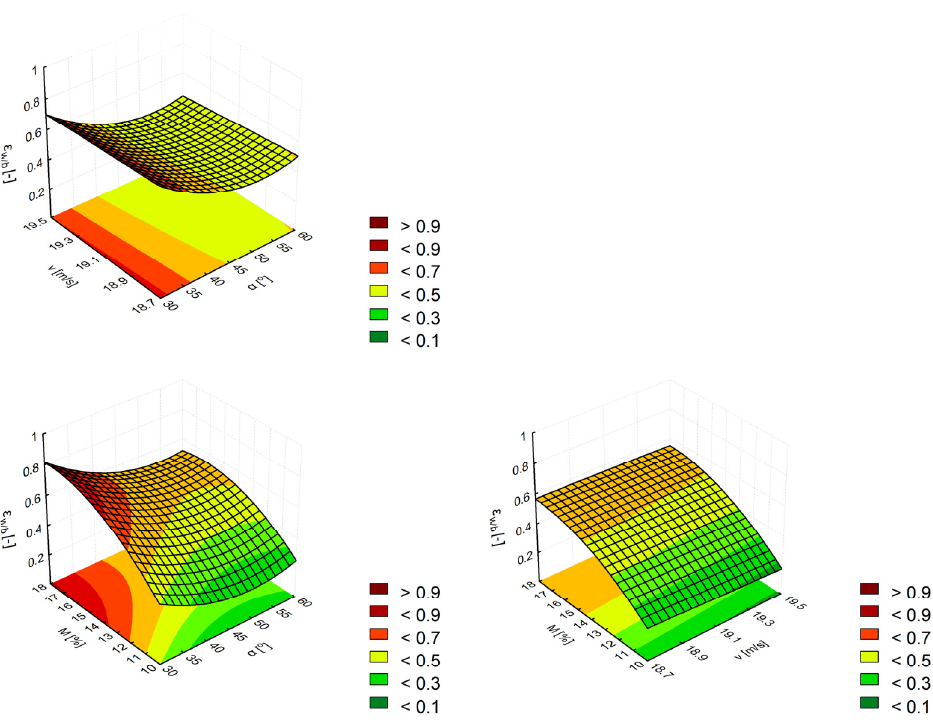
Figure 5. Separation efficiency index of the mixture of wheat kernels and buckwheat nutlets ( ε w / b ) for seeds with different moisture content ( M ), separated at different air stream velocities ( v ), and different cone apex angles ( α ).